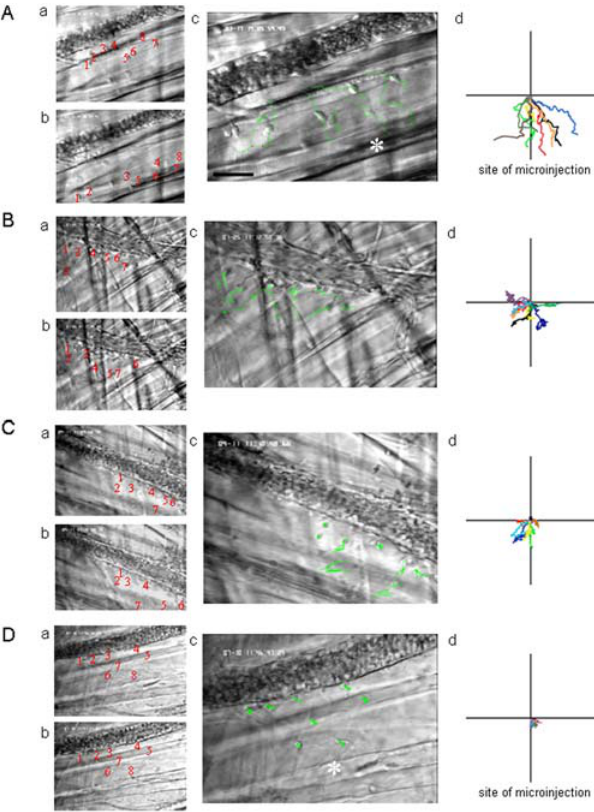
Figure 4. Leukocyte interstitial migration. Interstitially migrating leukocytes were visualized using near-infrared RLOT microscopy (objective magnification 20 6 ) and tracked during 5 min in digitized video recordings using an imaging software. A - leukocyte interstitial migration after microinjection of MIP-1 a , B - after intrascrotal injection of PAF, C – upon intrascrotal injection of MIP-1 a , and D - after microinjection of MIP-1 a followed by superfusion of the Rho kinase inhibitor Y27632. a - red numbers on the intravital microscopic images shows the position of each analyzed leukocyte at the beginning of cell tracking; b - location of the same leukocytes at the end of the cell tracking, respectively; c - green lines on intravital microscopic images and colored lines on the panels (d) show the migration tracks of single leukocytes; asterisks show the site of microinjection, scale bar 20 m m.